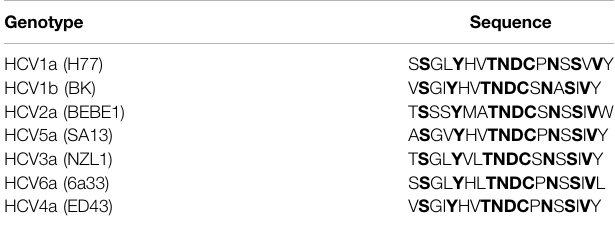
TABLE 4 | Sequence alignment of region 197 – 214 across various genotypes. In bold are represented the highly conserved residues.